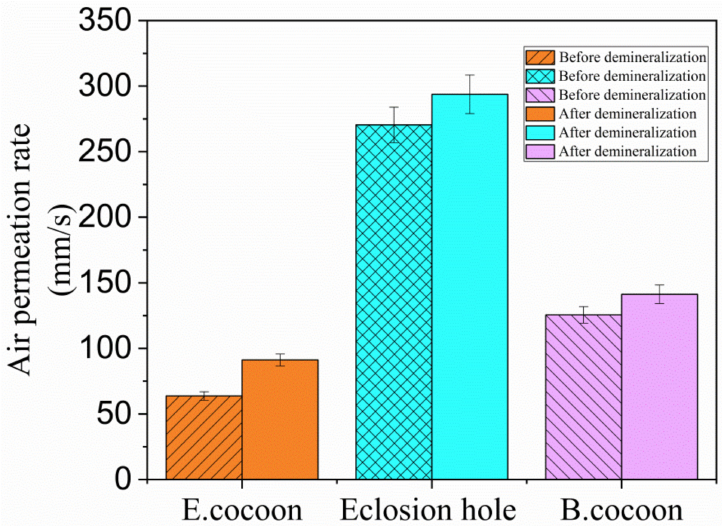
Figure 7. Air permeability rate values of E and B cocoons before and after demineralization.